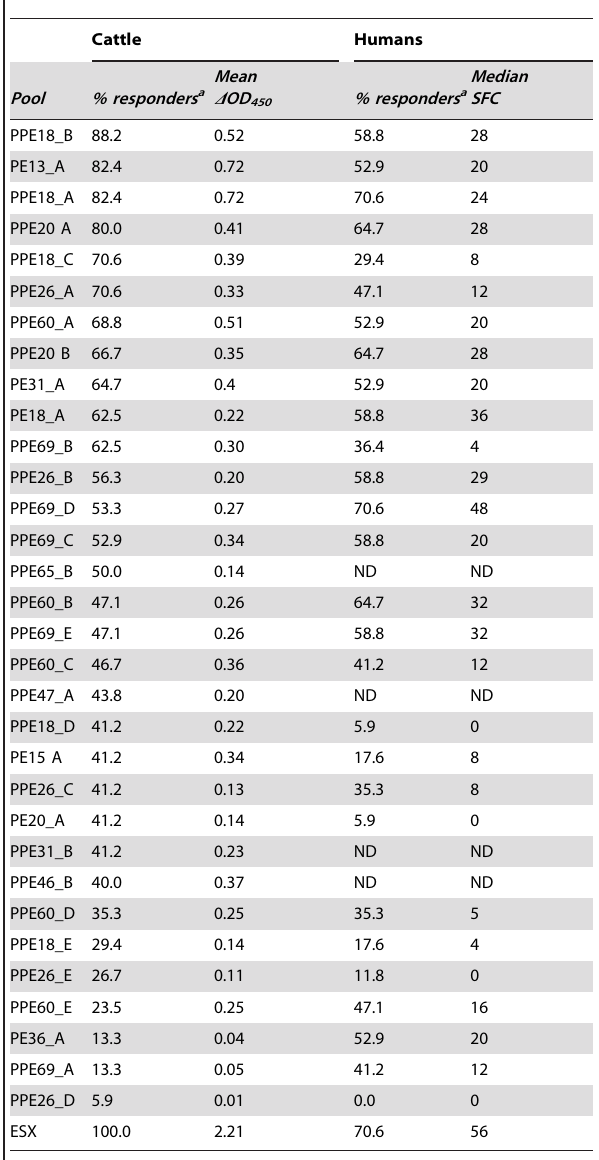
Table 2. Bovine and human responses to selected PE/PPE peptide pools.